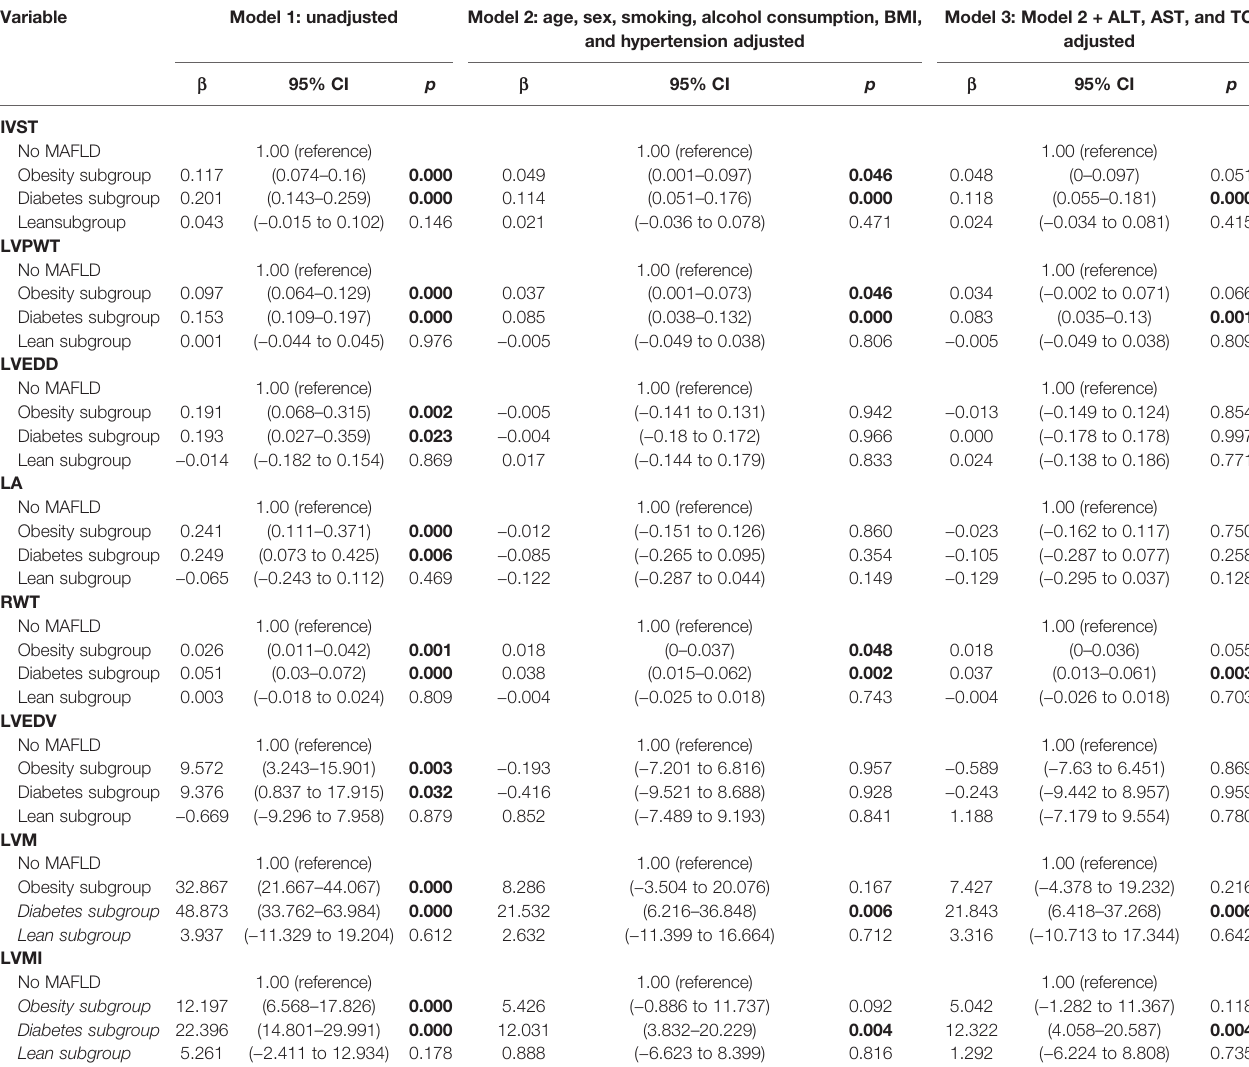
TABLE 6 | Multivariable linear regression analysis assessing the in fl uence of subgroups of MAFLD on echocardiographic markers of myocardial morphology. Variable Model 1: unadjusted Model 2: age, sex, smoking, alcohol consumption, BMI, Model 3: Model 2 + ALT, AST, and TC and hypertension adjusted